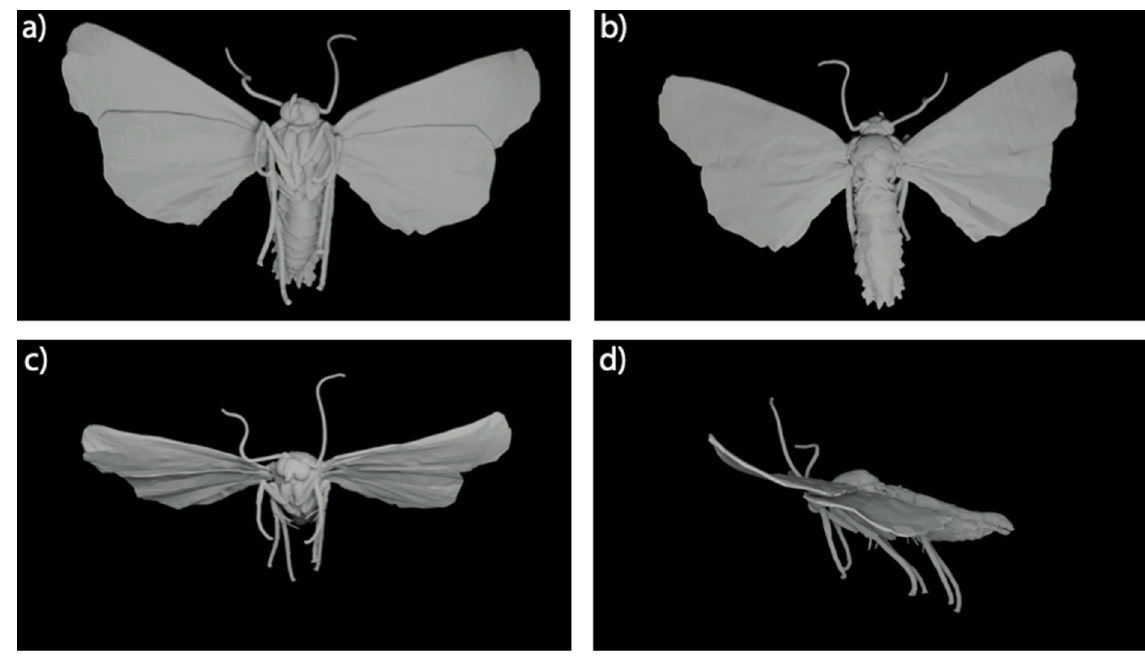
Figure 2. Depictions of the ( a ) ventral/bottom, ( b ) dorsal/top, ( c ) anterior/front, and ( d ) lateral/left- hand side views of the final 100% 3D model of the noctuid moth specimen.